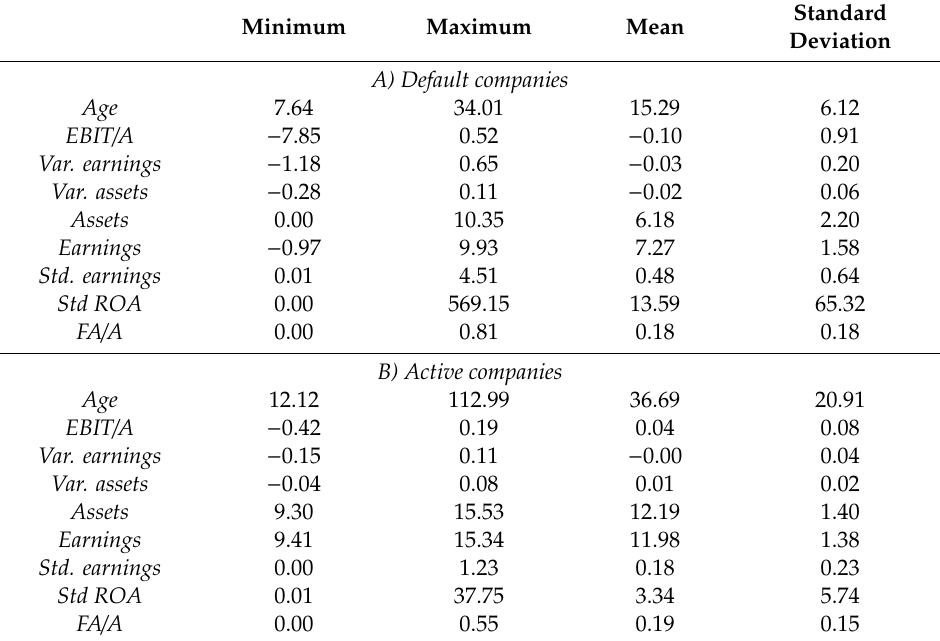
Table 2. Descriptive statistics of selected variables.